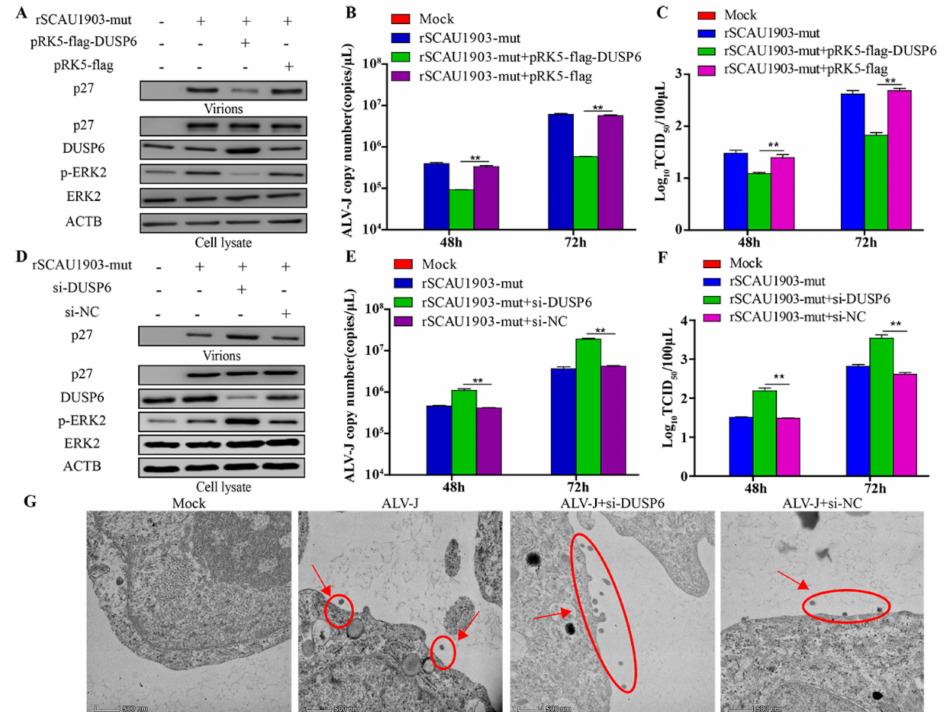
Figure 5. DUSP6/ERK2 pathway inhibits ALV-J replication. ( A – C ) DF-1 cells respectively transfected with pRK5-flag-DUSP6 plasmid and pRK5-flag plasmid were infected with ALV-J rSCAU1903-mut at 4 hpt. ( A ) The expression of p27 protein were examined by Western Blot. ( B ) The transcriptional level of viral particles in supernatants were measured by RT-PCR. ( C ) The supernatants from infected cells were titrated in DF-1 cells by ELISA for TCID 50 . ( D – F ) DF-1 cells respectively transfected with si-DUSP6 and si-NC were infected with ALV-J rSCAU1903-mut at 4 hpt. ( D ) The expression of p27 protein were examined by Western Blot. ( E ) The transcriptional level of viral particles in supernatants were measured by RT-PCR. ( F ) The supernatants from infected cells were titrated in DF-1 cells by ELISA for TCID 50 . ( G ) Si-DUSP6 was transfected into DF-1 cells and si-NC was used as a control. DF-1 cells were infected with ALV-J rSCAU1903-mut at 4 hpt and processed for transmission electron microscopy as described in Materials and Methods. Statistically significant values are indicated by ** p < 0.01.